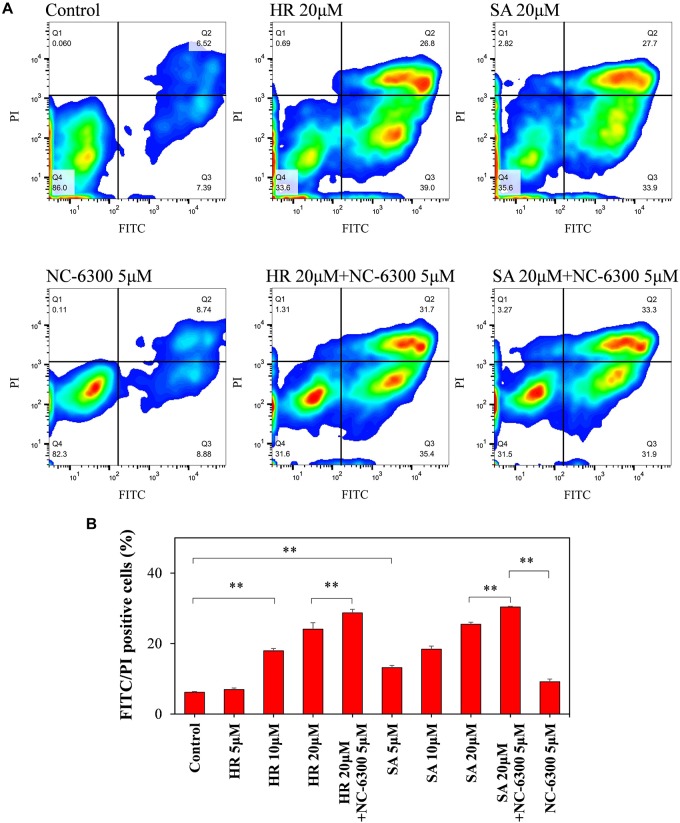
Flow cytometry analysis of HL-60 cells. The cell suspension was dispensed into test tubes and hydroxyl radicals (HR) or superoxide anions (SA) were added by Fenton reaction or xanthine/xanthine oxidase reaction. After 6-h incubation at 37°C, the samples were measured by flow cytometry. (A) FITC and PI intensity changes were monitored to confirm changes in the cell membrane upon extracellular addition of ROS and NC-6300. (B) Percentage of the number of FITC- and PI-double-positive cells (Q2 region). Three samples were collected form each group and the results are presented as the mean ± standard deviation. ∗∗P < 0.01, comparison for each pair by Tukey–Kramer test.